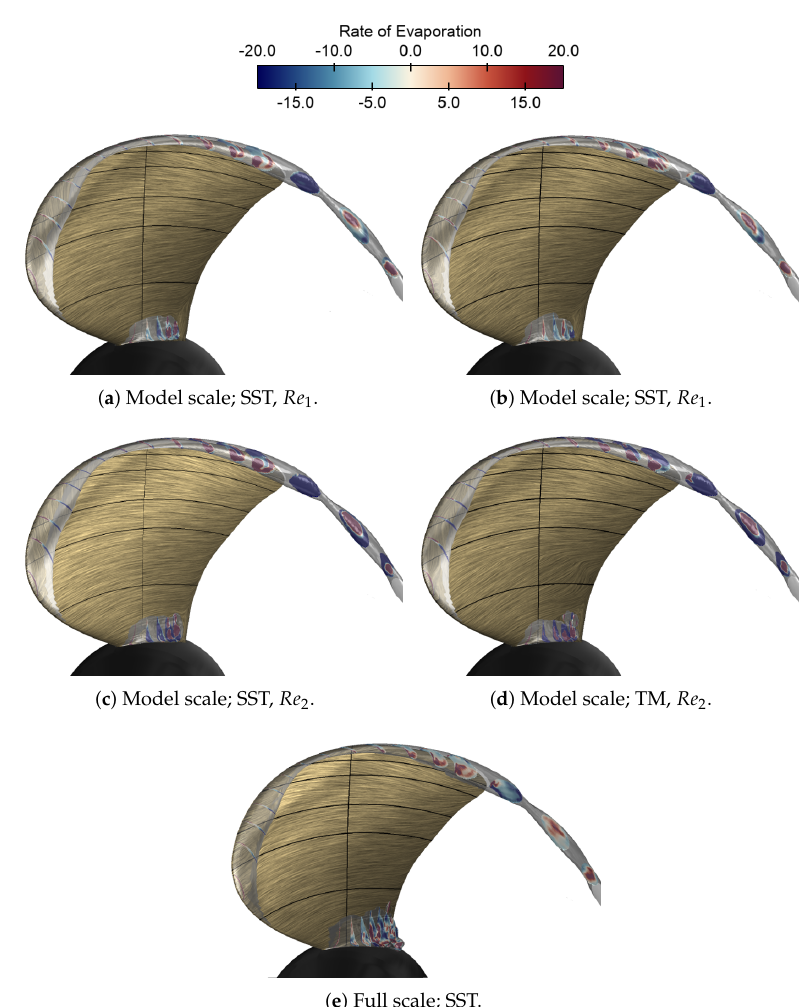
Figure 24. Rate of evaporation [kg/m 3 s] within the cavity volume in model and full scale for the PPTC Case